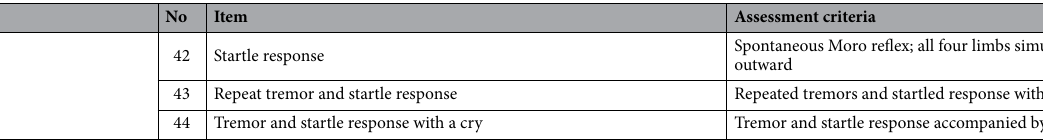
Table 4. Items of Infant’s Behaviour Checklist (IBC) and assessment criteria. *Assessed only during the early infancy